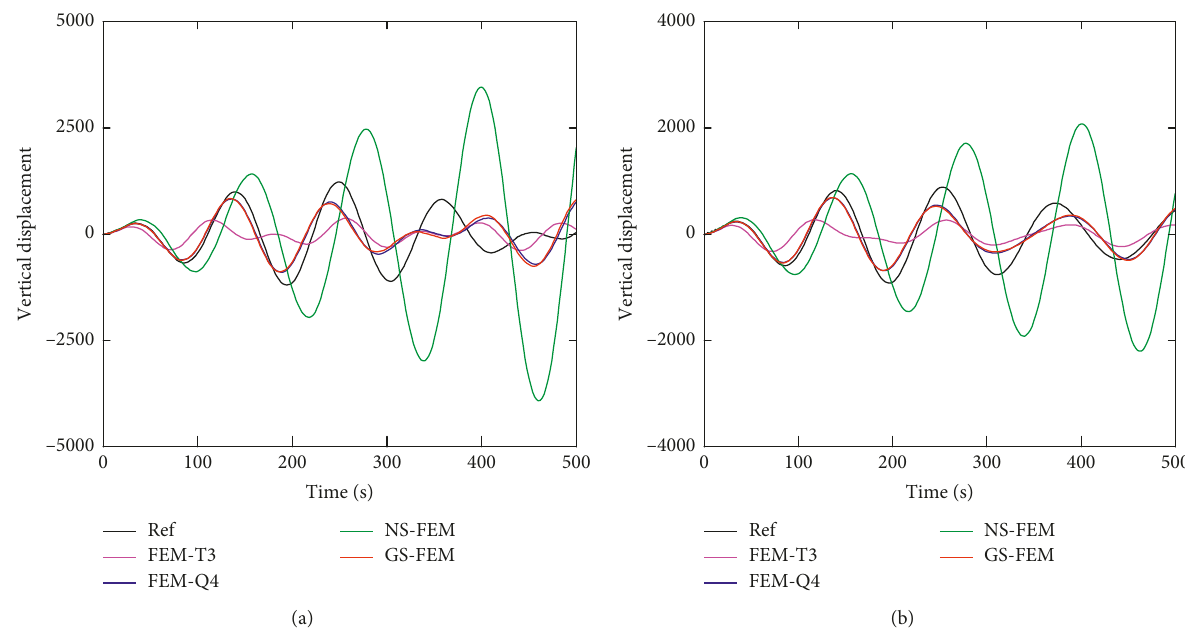
Figure 31: Transient response of the cantilever beam subjected to harmonic loading with ω